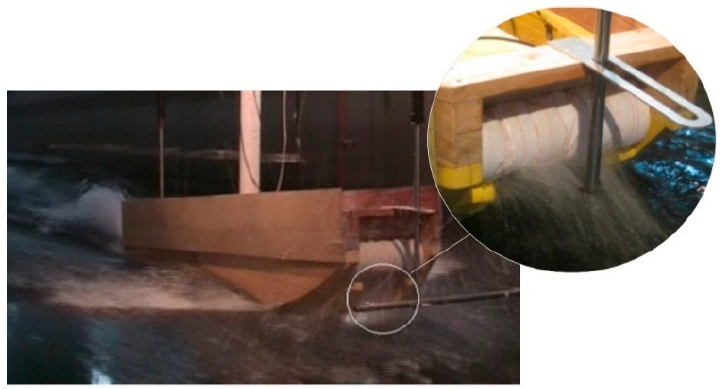
Figure 10. Spray under the bow seals when the hull is rising.